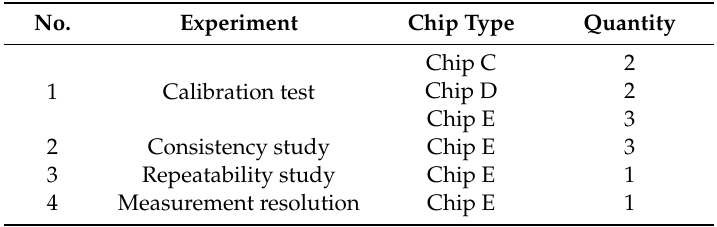
Figure 3. Experimental setup diagram inside the thermostat chamber. Table 2. Parameters of the temperature sensors used in different experiments.